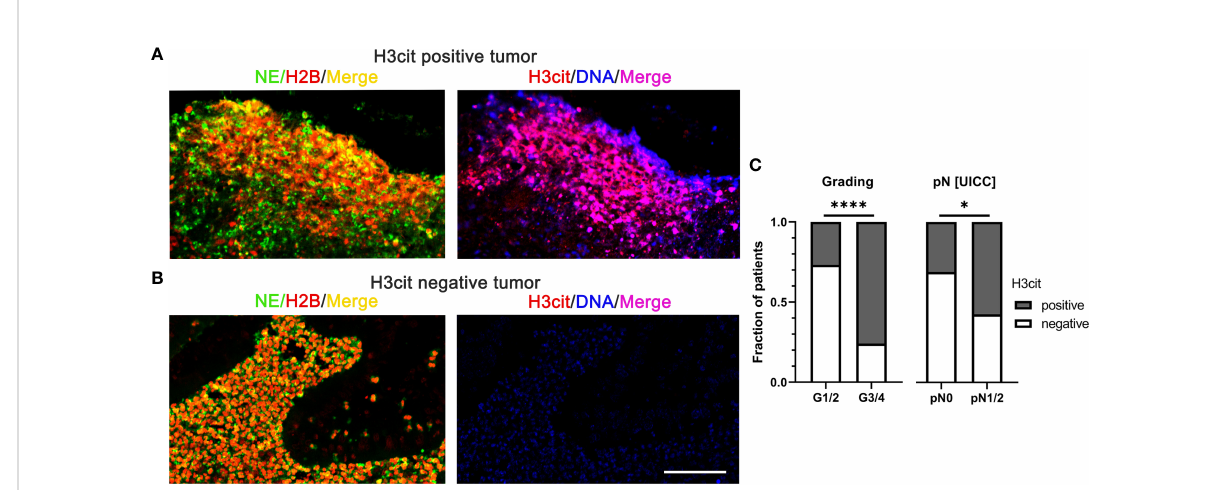
FIGURE 3 NETs in colorectal cancer identi fi ed by interstitial H3cit are associated with high histopathological tumor grades and lymph node metastasis in human CRC. (A, B) NE, H2B, and H3cit were used to detect NET formation on consecutive sections of CRC by immuno fl uorescence. Draq5 served as counterstain. Notably, regions with extranuclear H3cit colocalize with NE H2B in consecutive sections. Extracellular DNA detected by anti-DNA antibody is restricted to H3cit positive tissues. Scale bar: 75µm. (C) In human CRC tissues, NETs identi fi ed by H3cit positively correlated with high histopathological grading and lymph node metastasis. Results taken from [55], © [2022] Pathological Society of Great Britain and Ireland, fi rst published by John Wiley & Sons Ltd. H2B, histone H2B; H3cit, citrullinated histone 3; NE, neutrophil elastase; NETs, neutrophil extracellular traps. ****p < 0.0001, *p <